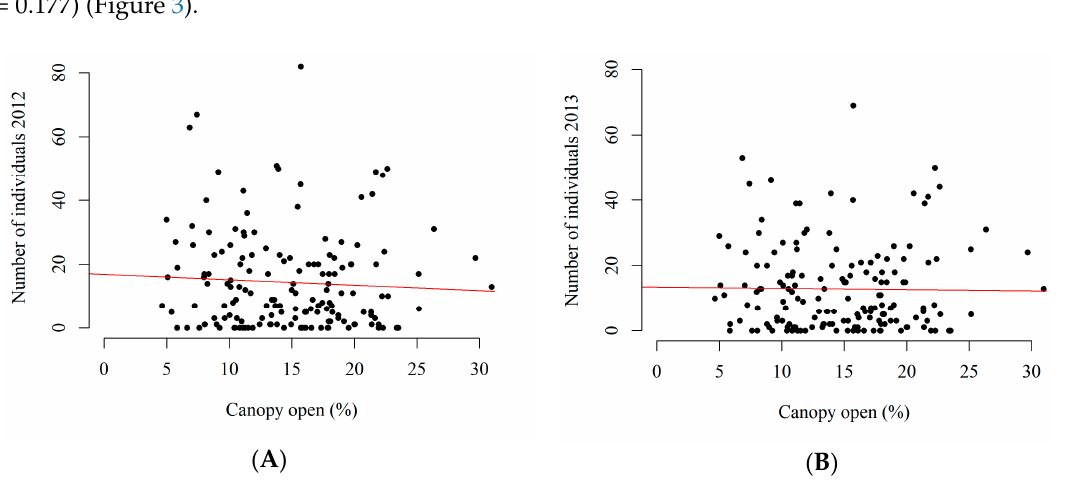
Figure 3. Number of regenerating individuals of M. paraensis in 2012 ( A ) and 2013 ( B ), as a function of canopy openness as measured in 2012, in estuarine floodplain forests of the Amazon River, municipality of Mazagão, state of Amapá, eastern Amazon.